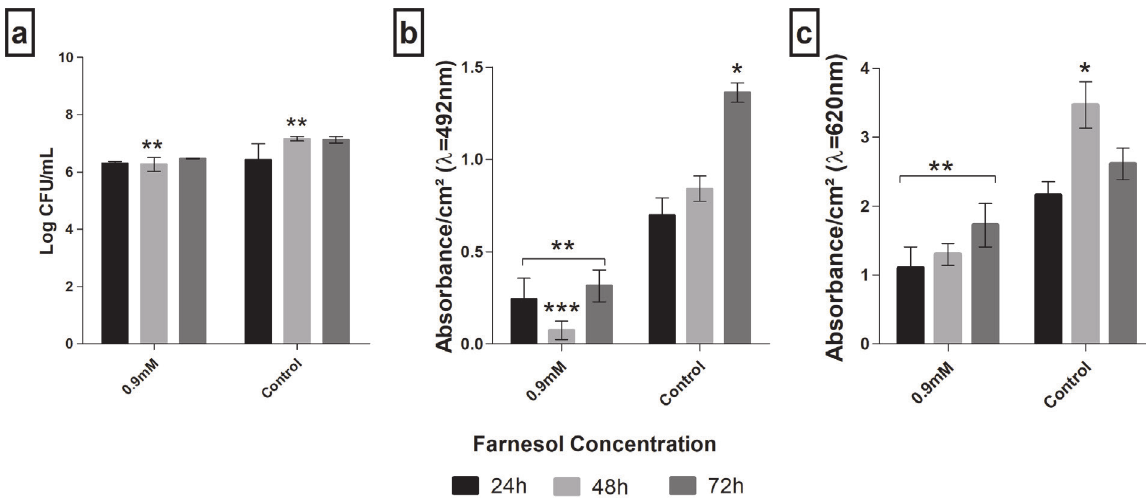
Figure 3. Influence of the concentration of farnesol on Rhodotorula mucilaginosa ATCC 64684 biofilm in formation over time by evaluation of three variables: (a) colony forming units (CFU); (b) metabolic activity (XTT); and (c) total biomass production (CV). Farnesol reduced metabolic activity and total biomass and therefore the production of extracellular matrix, since CFU/mL remained high, independent of time. *Statistical difference between controls. **Statistical difference between controls and treated. ***Statistical difference at 24 and 48 hours of treatment. Control: a similar experiment without farnesol. All tests were performed in triplicate and on three independent days. Data with a non-normal distribution were expressed as the mean ± standard deviation